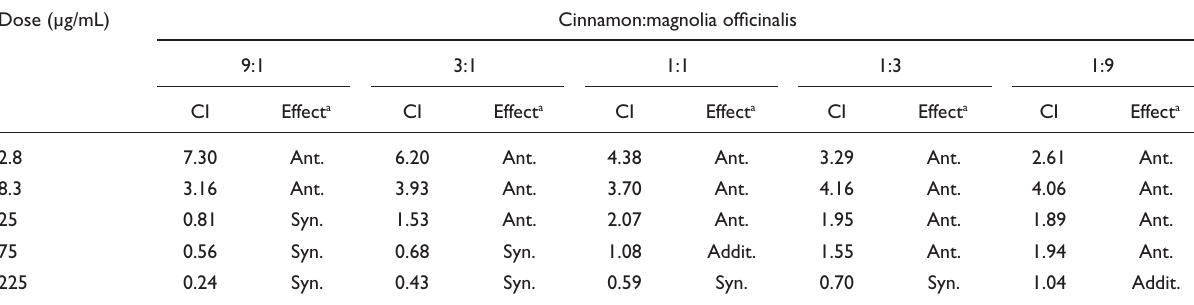
a Ant. means antagonism, Addit. means additive, and Syn. means synergy.